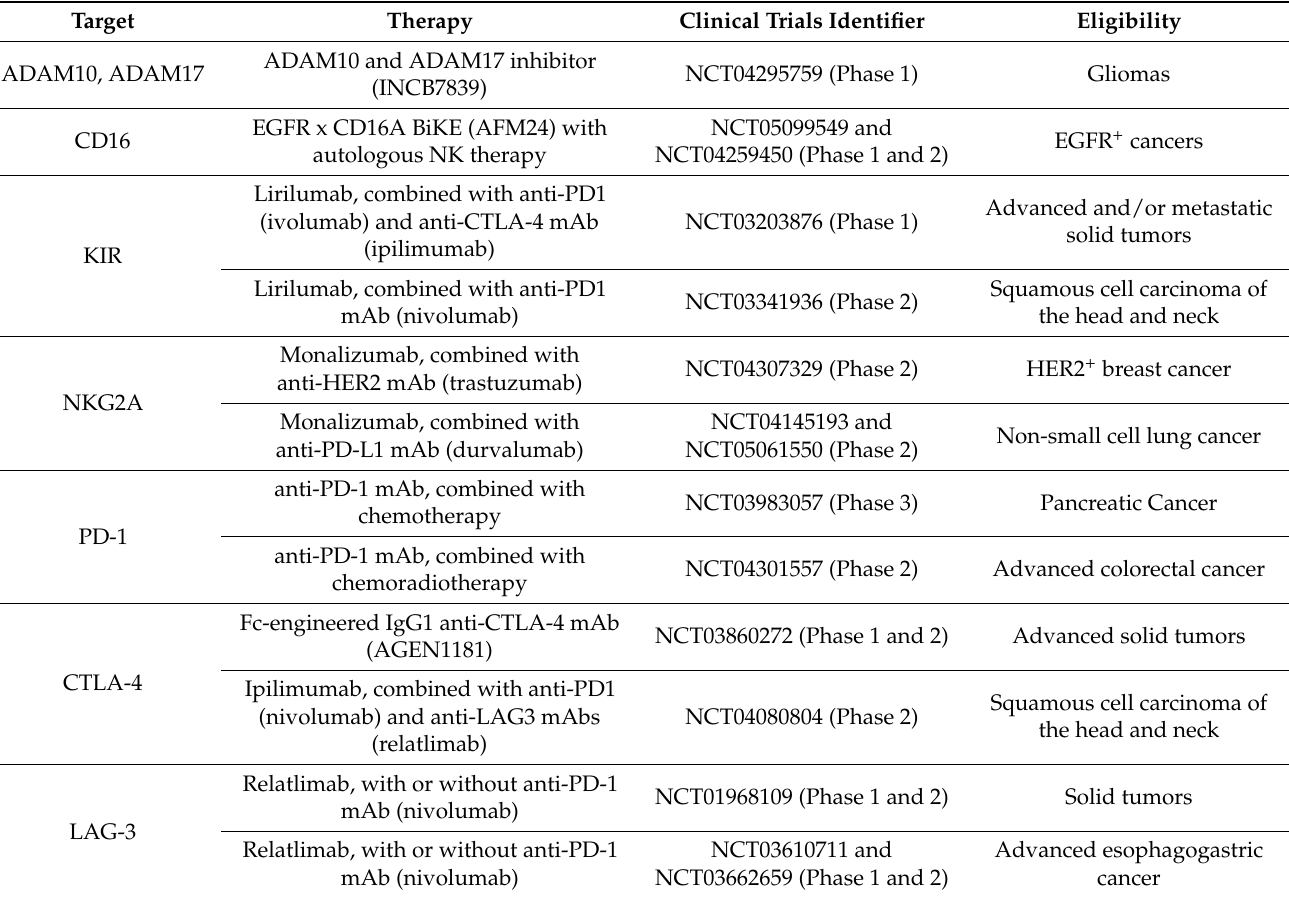
Table 1. Selected ongoing clinical trials targeting NK recognition and